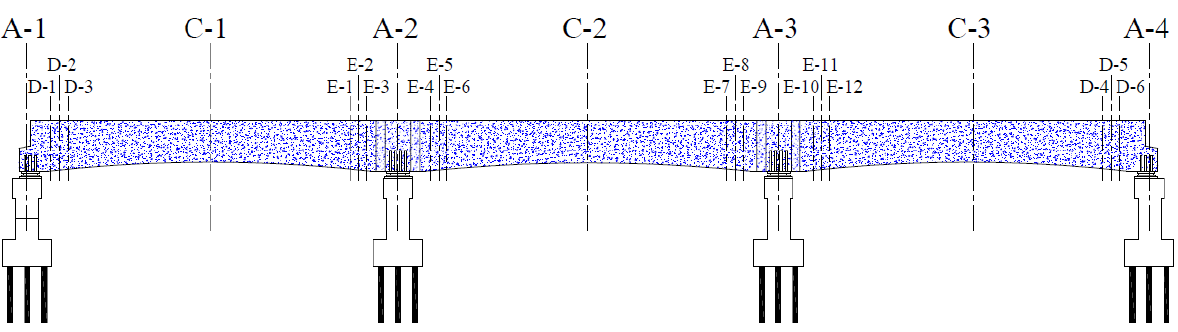
Figure 8. Details of locations for strain gauges (SP-1).